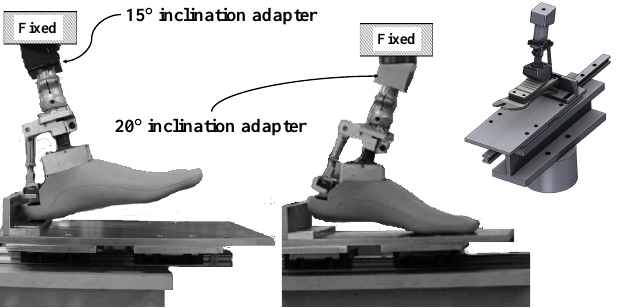
Figure 16. ISO 1328 equivalent static tests: actual plantarflexion and dorsiflexion tests and 3D Cad model of the test set up, in plantarflexion test